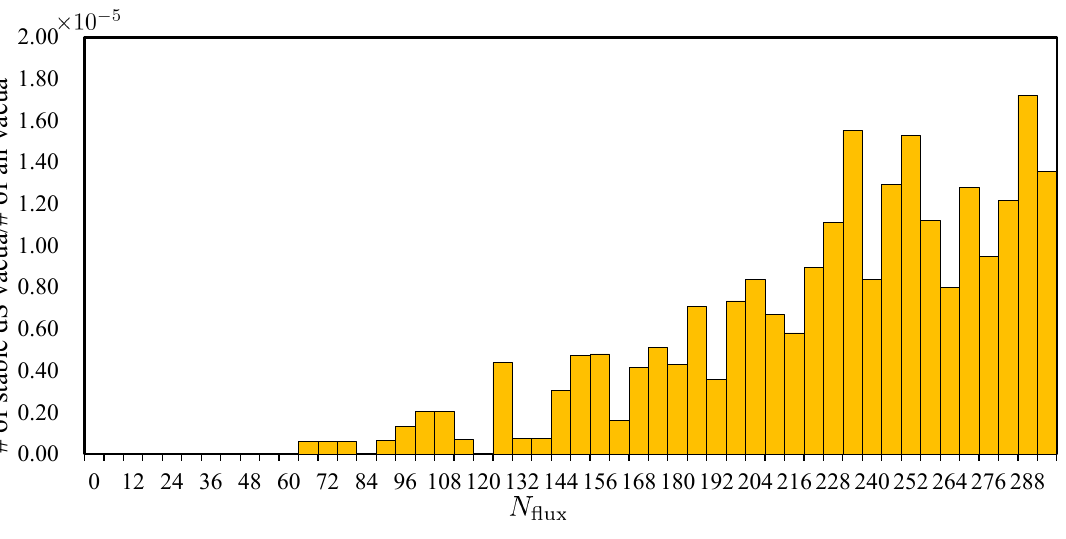
Figure 9 . The ratio of the number of stable dS vacua and that of all vacua against N flux